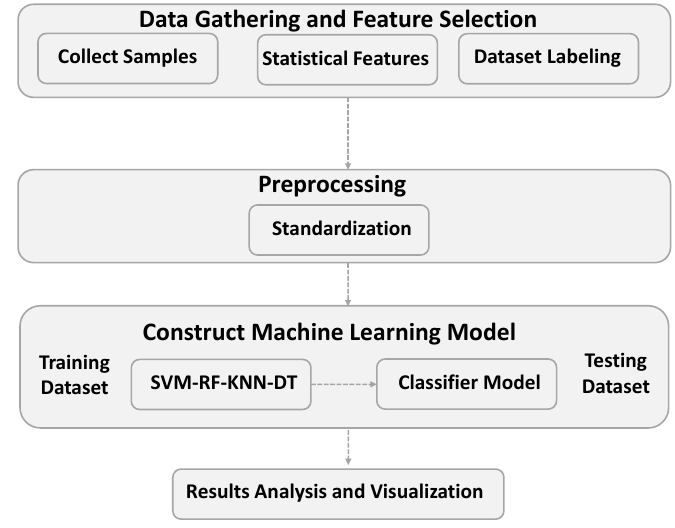
Figure 3. Steps to build and evaluate proposed machine learning algorithms.